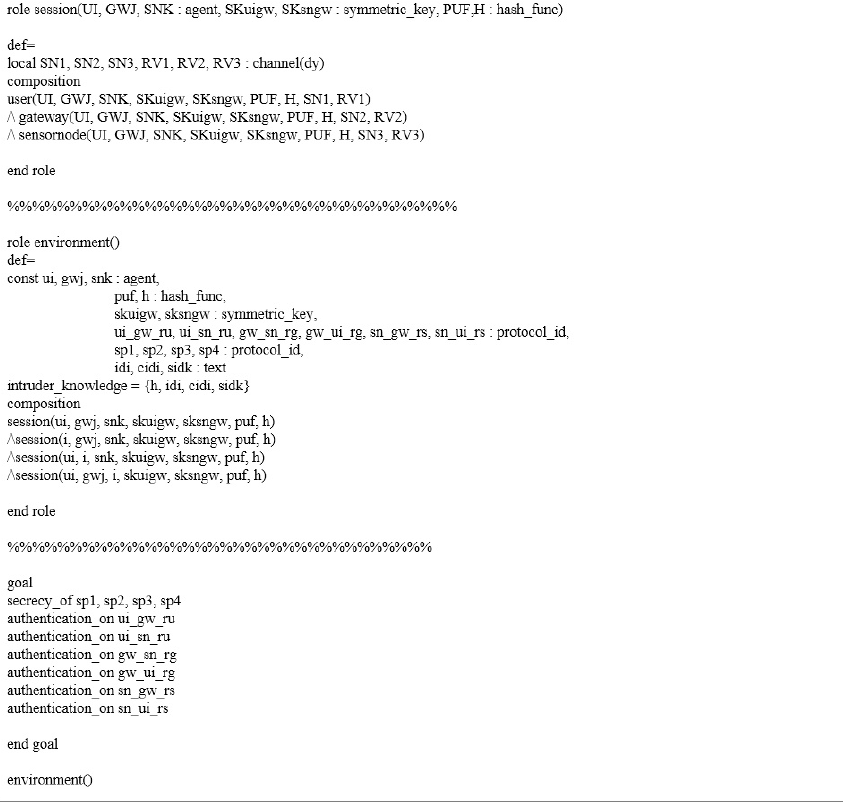
Figure 9. Role specification for the session, environment, and